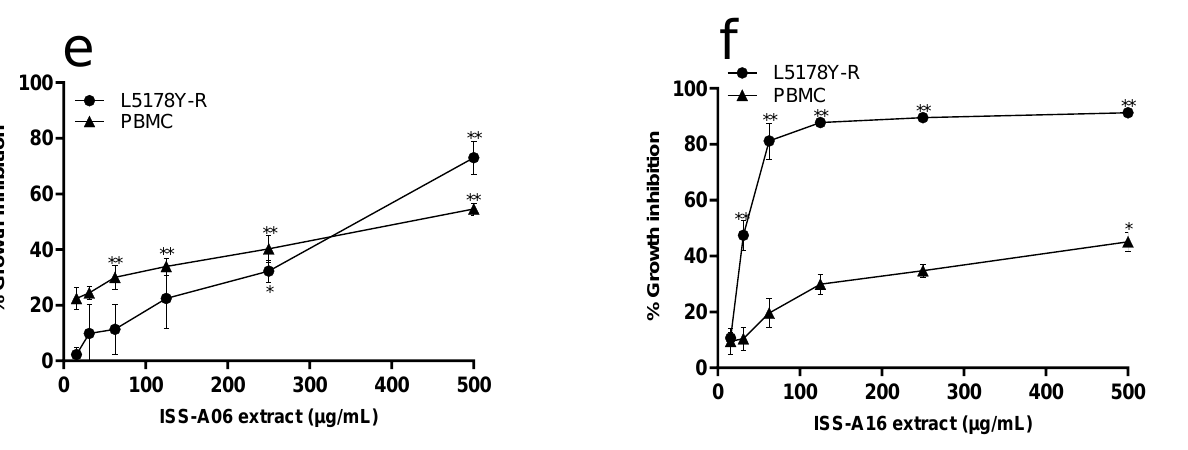
Figure 2. Tumor cell growth inhibition by methanol extracts from I. sonorae endophytic and rhizo- sphere bacteria cultures. L5178Y-R cells were placed at a concentration of 1 × 10 4 cells/well and PBMC at 2 × 10 5 cells/well, and treated with ethyl acetate bacterial extracts at concentrations ranging from 15.62 µg/mL to 500 µg/mL for 48 h. ( a ) ISE-B22, ( b ) ISE-B26, ( c ) ISE-B27, ( d ) ISS-A01, ( e ) ISS- A06, and ( f ) ISS-A16. Cell growth inhibition was assessed by the MTT reduction assay, measuring ODs at 570 nm. Vincristine (VC) was used as a positive control at a concentration of 0.05 µg/mL, as detailed in the text. VC caused 69.98% and 16% growth inhibition against L5178Y-R and PBMC, respectively. Data represent mean ± SD of triplicates from three independent experiments. * p < 0.05; ** p < 0.01, as compared with untreated control.